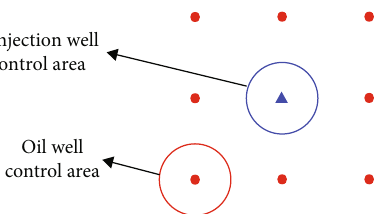
Figure 6: Schematic diagram of the seepage area of oil and water